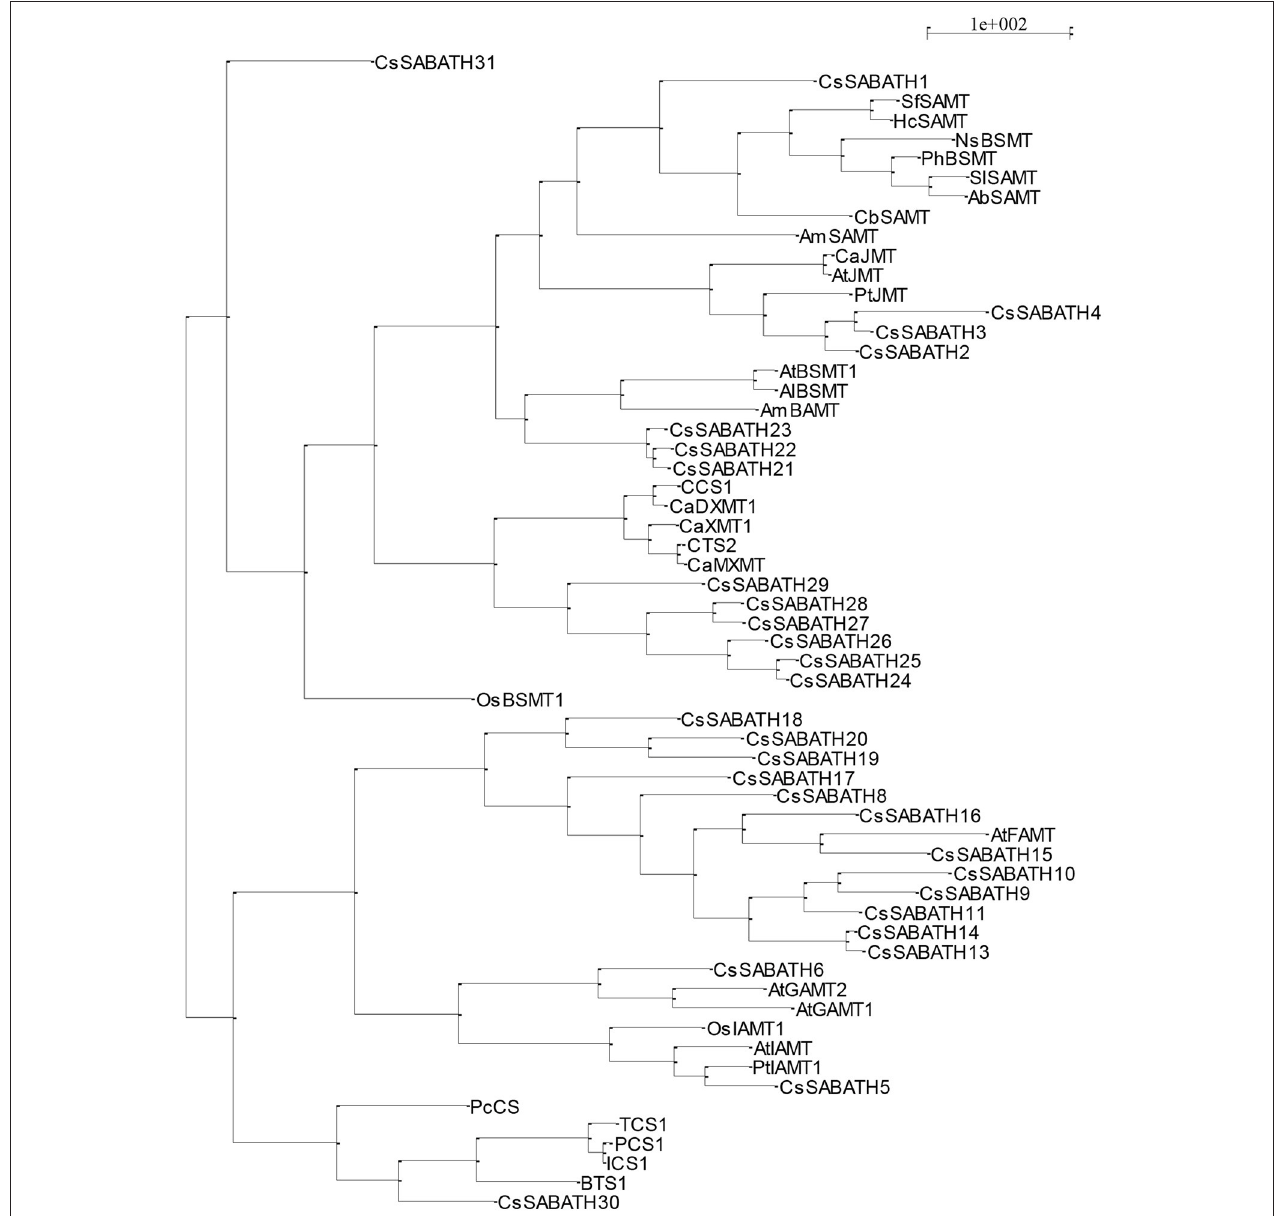
FIGURE 1 | Neighbor-joining, phylogenetic tree depicting the inferred evolutionary relationships between the 31 SABATH amino acid sequences mined from the Citrus sinensis genome and representative SABATH sequences from other plant species. Amino acid sequences and accession numbers for CsSABATH and representative sequences provided in Supplementary Files 1, 2 , respectively. Maximum parsimony produced three highly similar trees except for the internode placement of CsSABATH18, 19, and 20 (data not shown), one of which was identical to that produced by neighbor-joining. CsSABATH1 grouped with other known and characterized SAMTs and was named